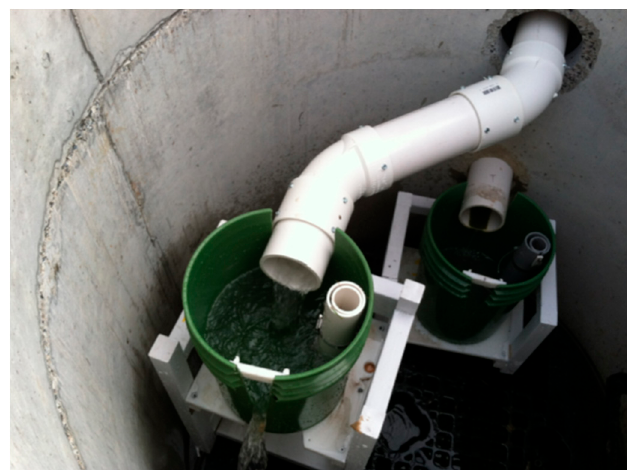
Figure 2. Modified 18.9 L buckets in a concrete manhole gauging tile drainage flows (background) and surface runoff (foreground).